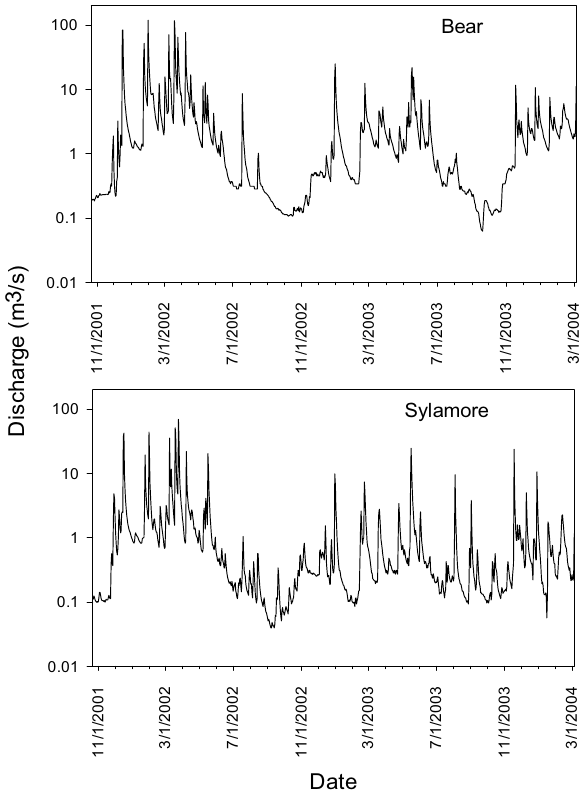
Figure 2. Bear (Runoff/Intermittent Flashy) and Sylamore (Groundwater Flashy) Creek hydrographs showing discharge (m 3 s −1 ) from 2002 to 2003. Source data USGS NWIS. Figure produced with R 34